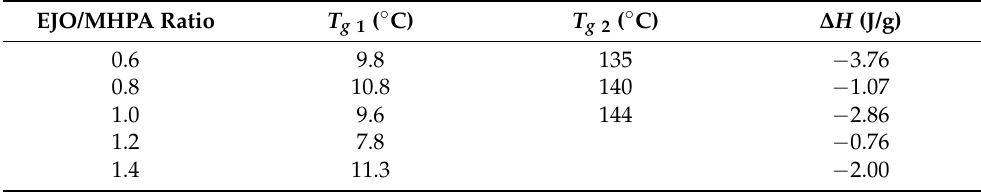
Figure 8. DSC curves of EJO/MHPA polymers with various ratios of anhydride to oxirane. Table 2. Thermal properties of EJO/MHPA polymers found in DSC